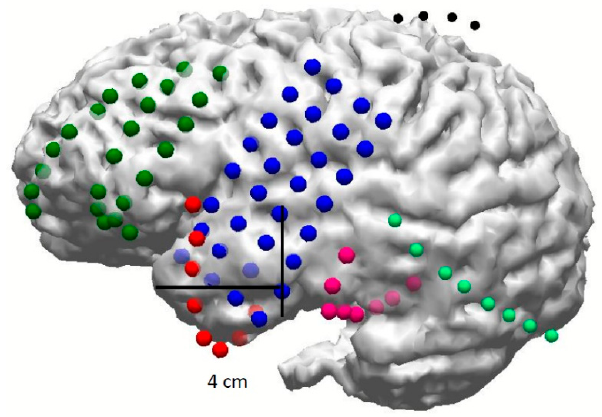
Figure 4. 3D rendering of baseline brain magnetic resonance imaging (MRI) and surgically implanted subdural electrodes (grids and strips).